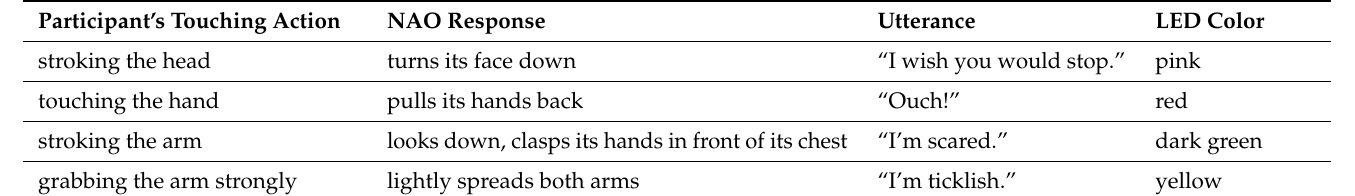
Figure 2. Frames from videos of appropriate reactions of NAO to human touch. ( a ) Case: stroking the head; ( b ) Case: touching the hand; ( c ) Case: stroking the arm; ( d ) Case: grabbing the arm strongly. Table 2. Contradictory response of NAO to each touching action.